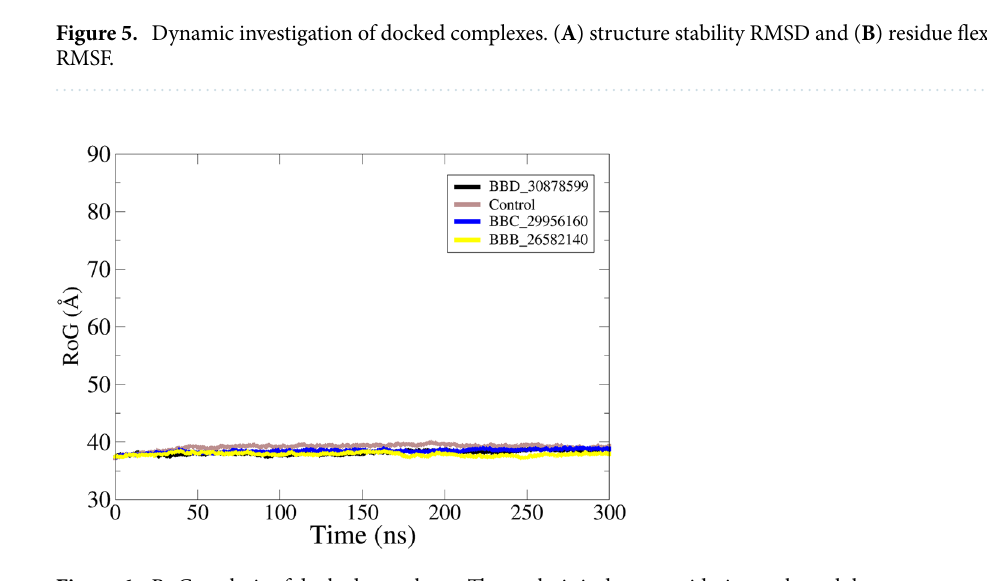
Figure 6. RoG analysis of docked complexes. The analysis is done considering carbon alpha